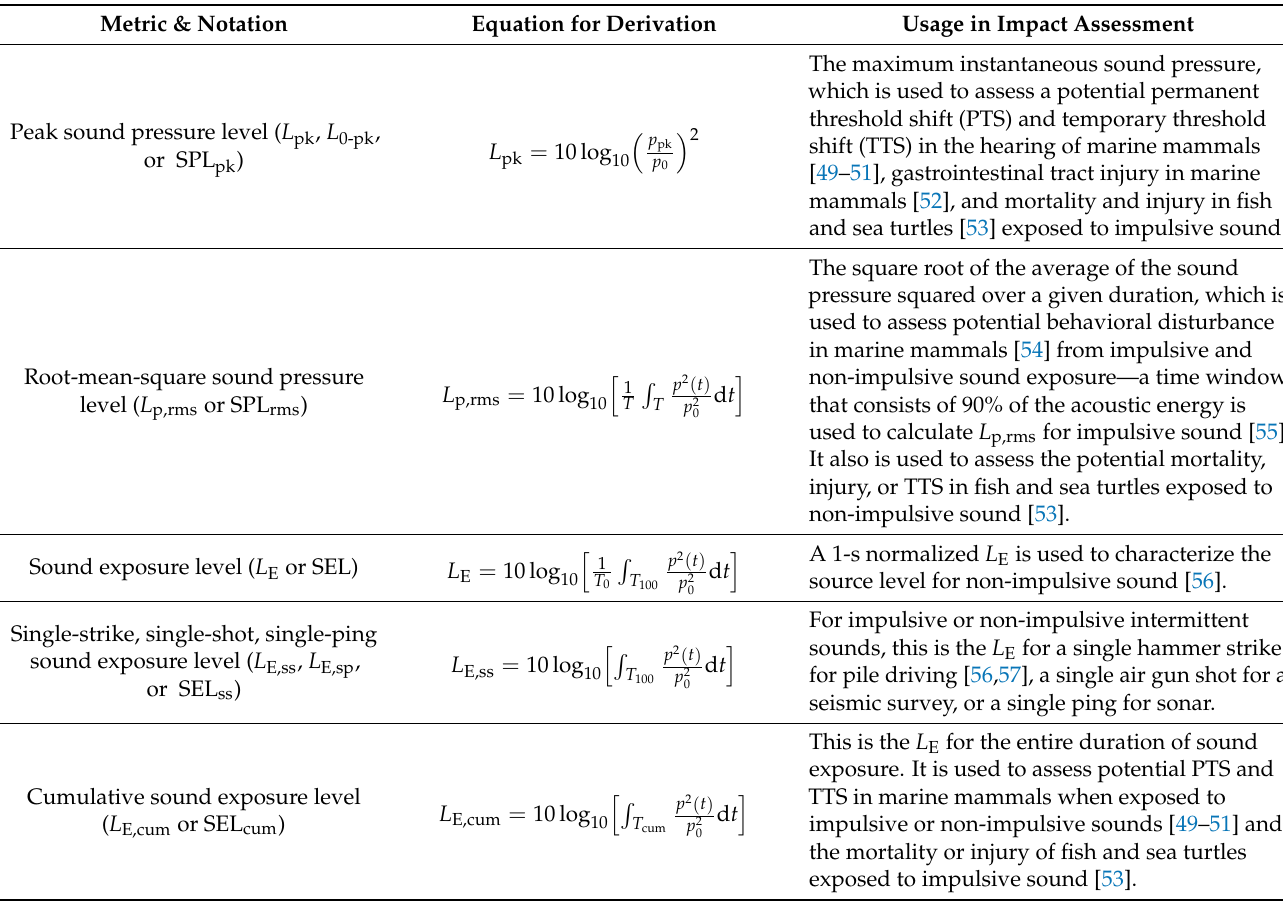
Table 1. Summary of the sound level metrics commonly used in assessing the impacts of underwater sound on marine life. Metric &